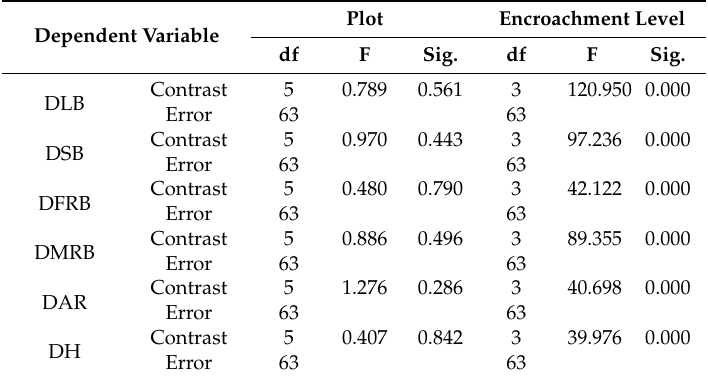
Table 3. The F tests the effect of the plot and of the encroachment level of D. angustifolia biomass, height, and leaf